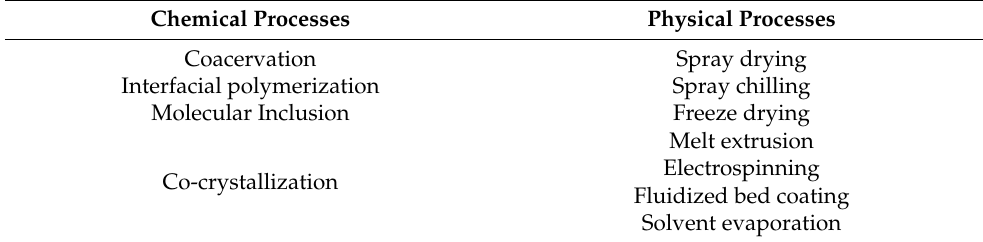
Table 1. Microencapsulation techniques